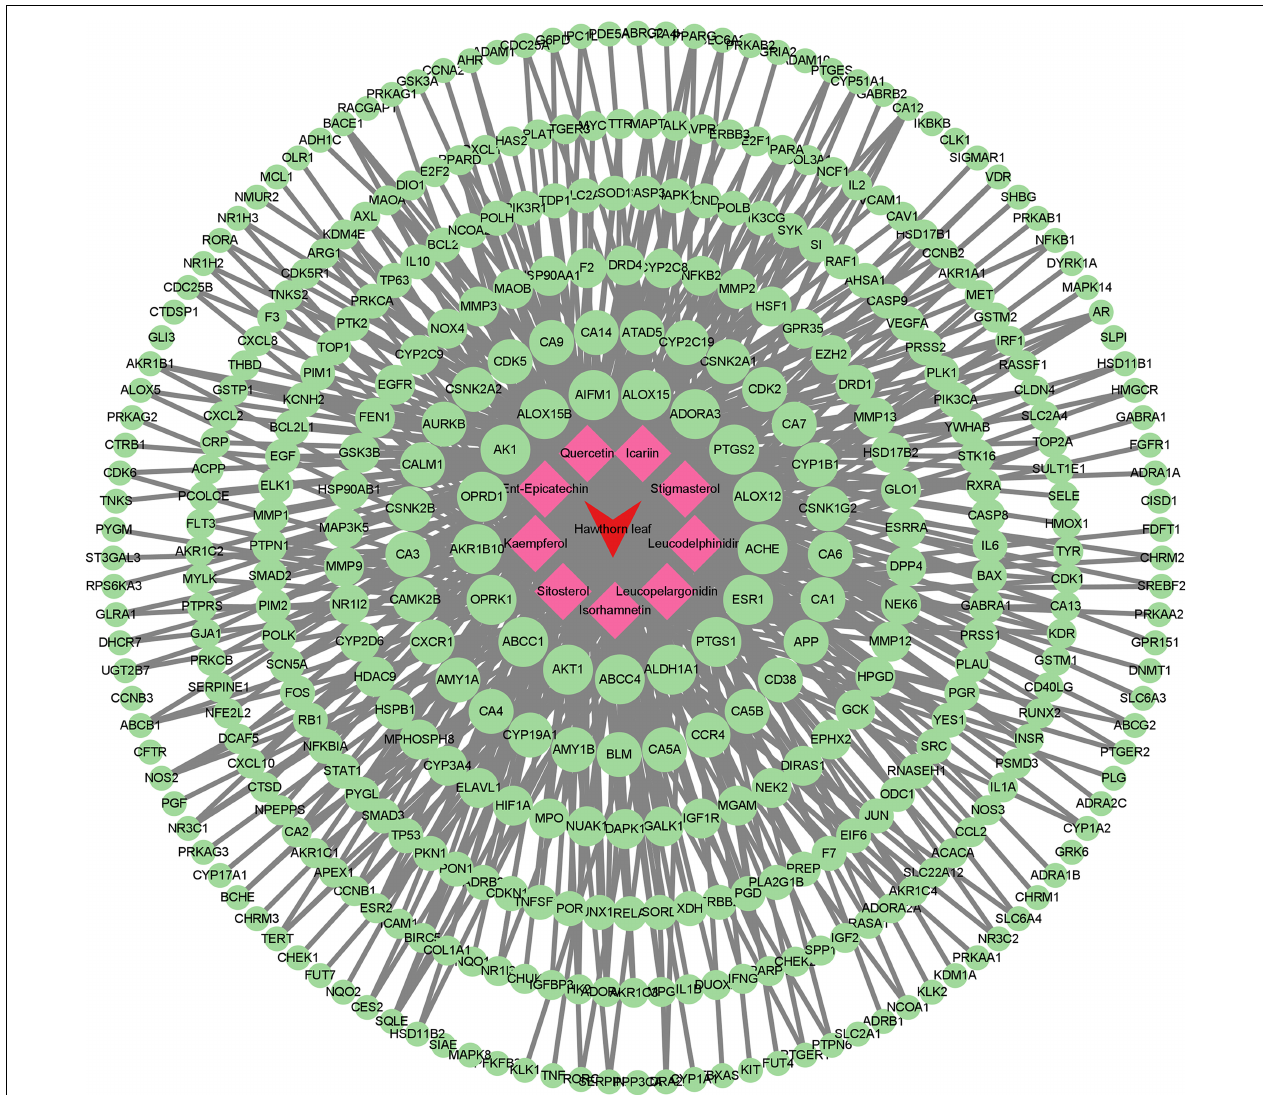
FIGURE 2 | Compound–target network. Red and green circular nodes represent active compounds and corresponding targets,